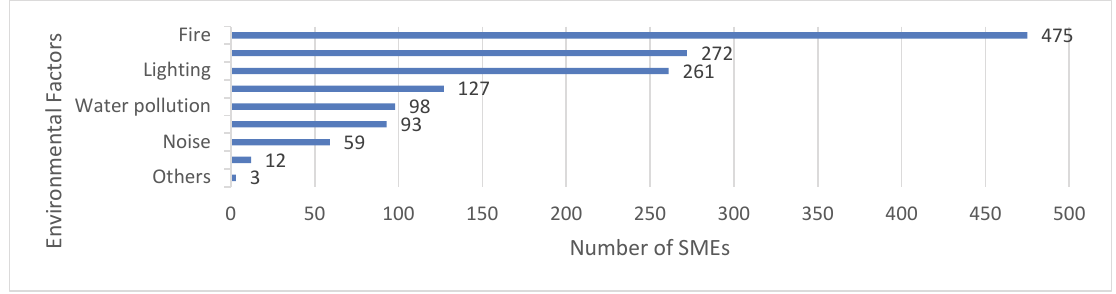
Fig. 2. Number of SMEs, by environmental factors